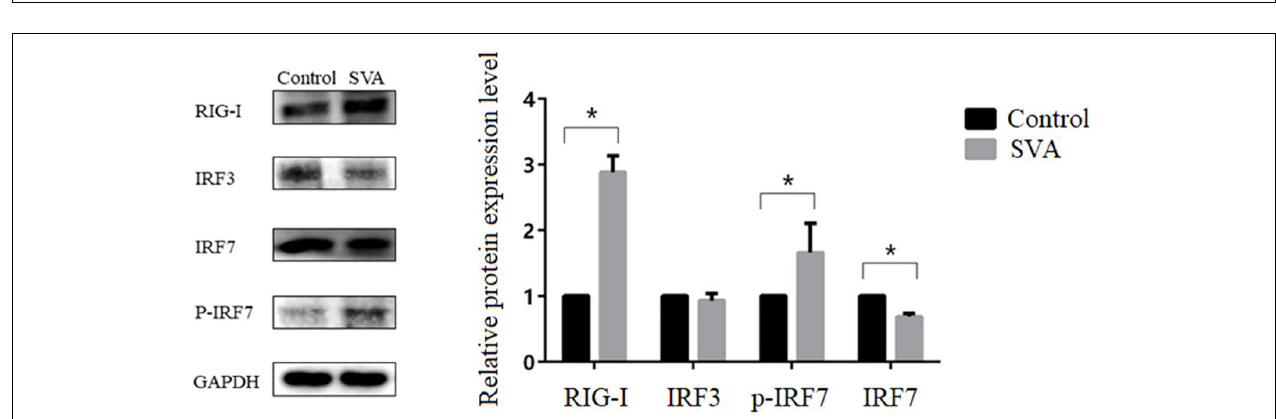
FIGURE 9 | The expression levels of related genes in PK-15 cells after SVA infection. The x -axis indicates the time post-infection, and the y -axis represents the fold changes after SVA infection (* P < 0.05). (A) The mRNA expression of IRF3. (B) The mRNA expression of RIG-1. (C) The mRNA expression of IRF7. (D) The mRNA expression of MDA-5. (E) The mRNA expression of MyD88. (F) The mRNA expression of MAVS.